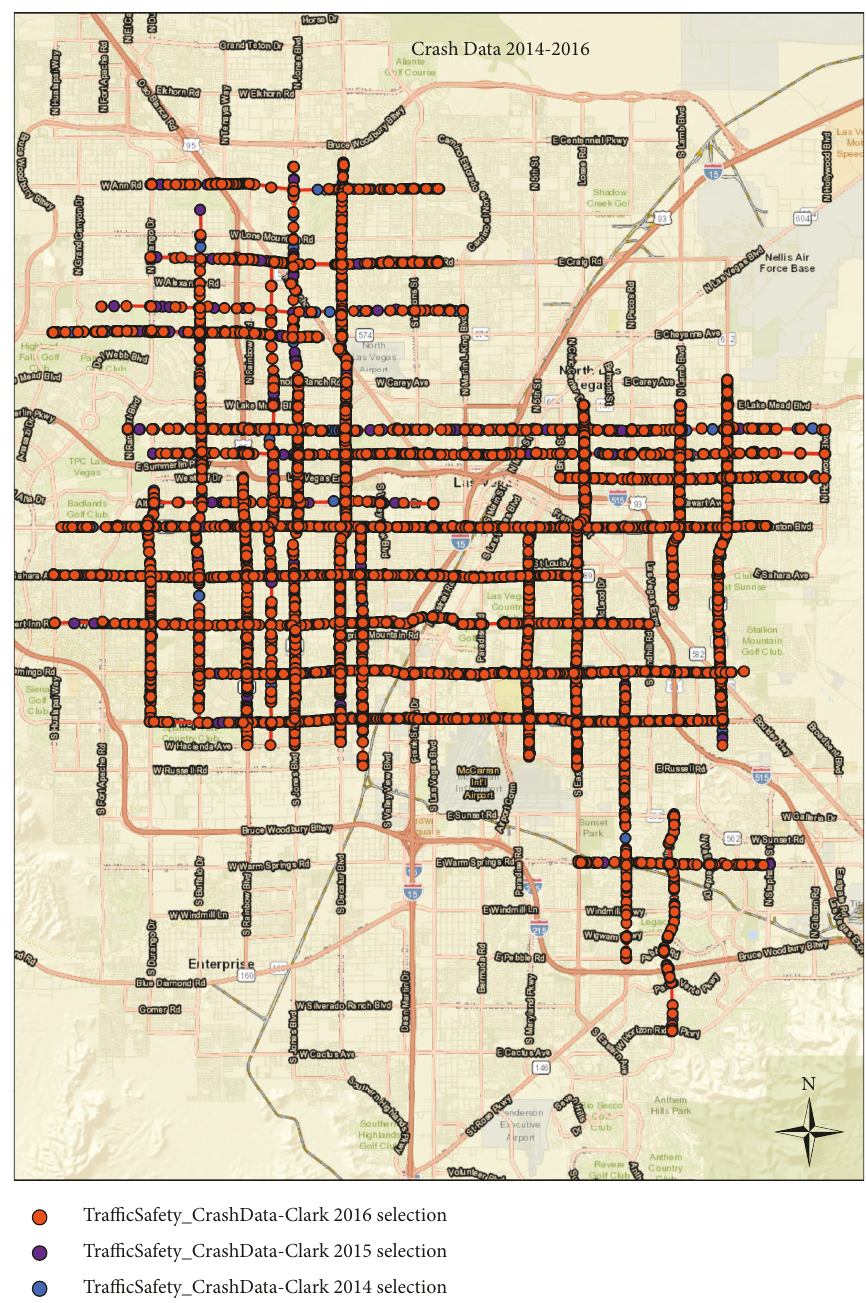
Figure 1: Selected arterials and crashes in Las